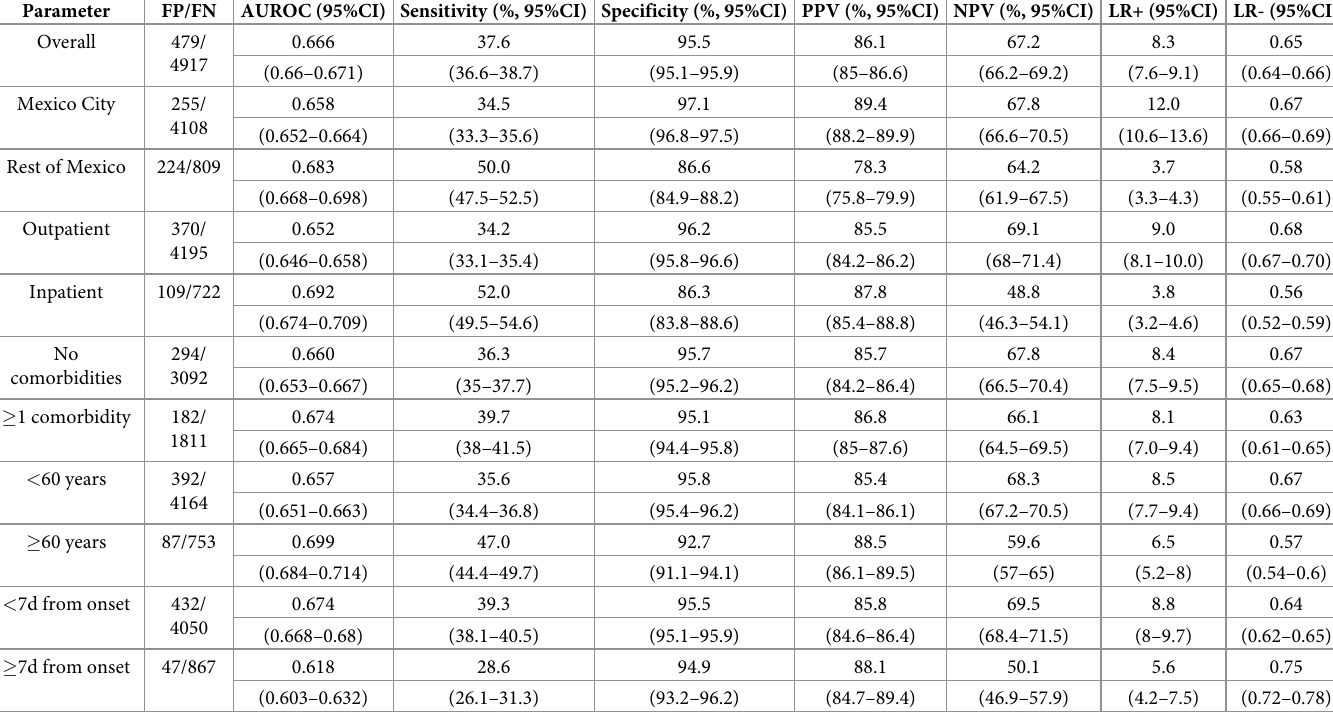
Table 2. Overall diagnostic performance metrics of rapid antigen tests to detect SARS-CoV-2 infection compared to qRT-PCR in Mexico and stratification by region of testing, patient setting, comorbidity, age and days from symptom onset to evaluation.